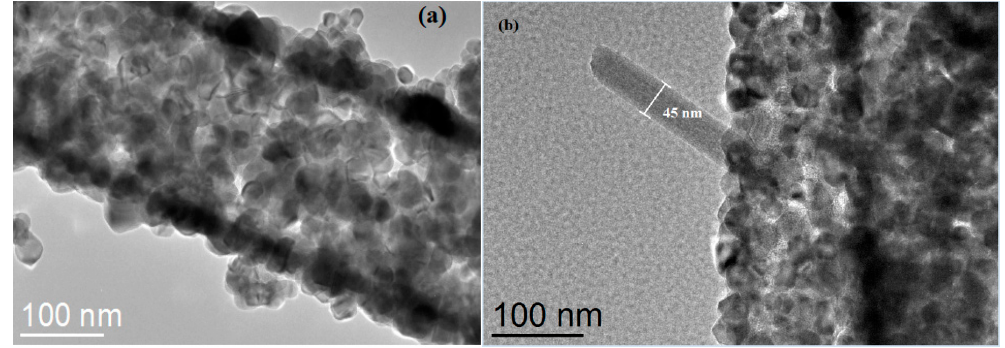
Figure 4. TEM images of ( a ) electrospun SnO 2 nanofibers and ( b ) SnO 2 /ZnO 3D hetero-nanofibers.